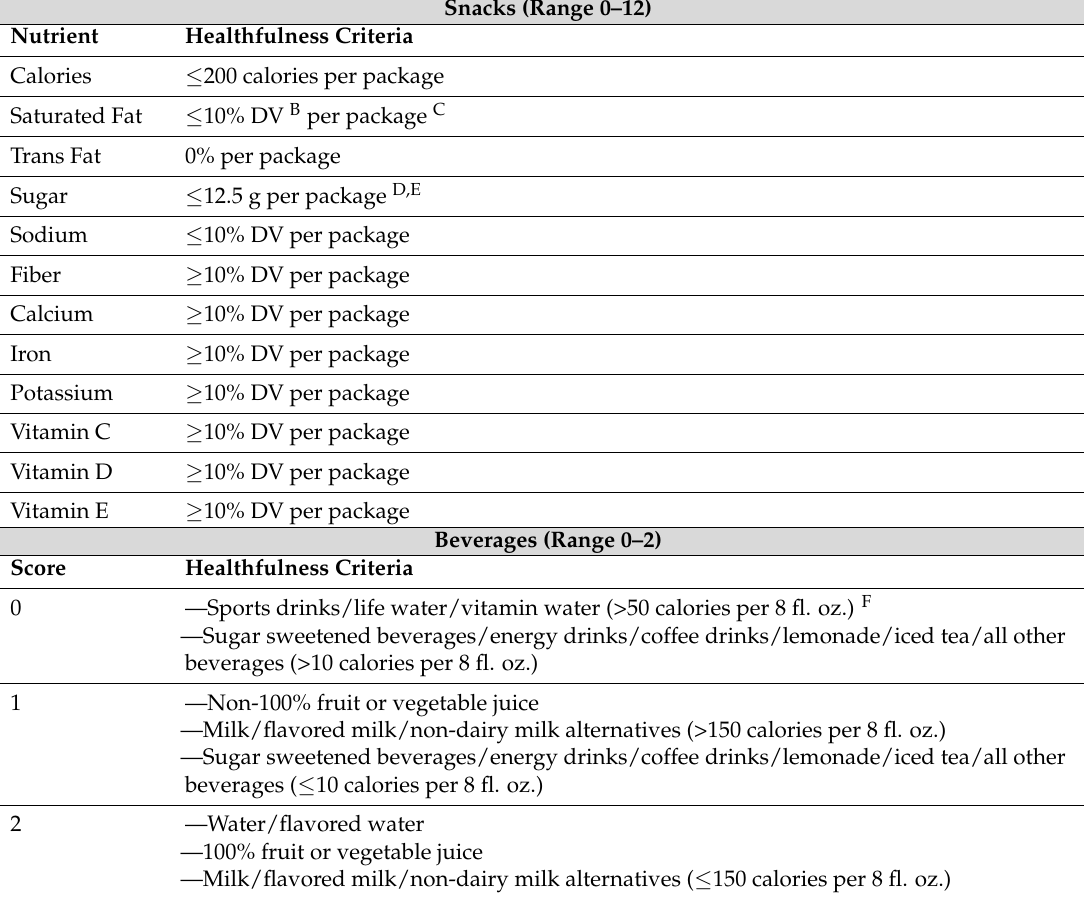
Table 1. Vending Evaluation for Nutrient-Density (VEND)ing nutrient-density healthfulness Criteria A [25]. Snacks (Range